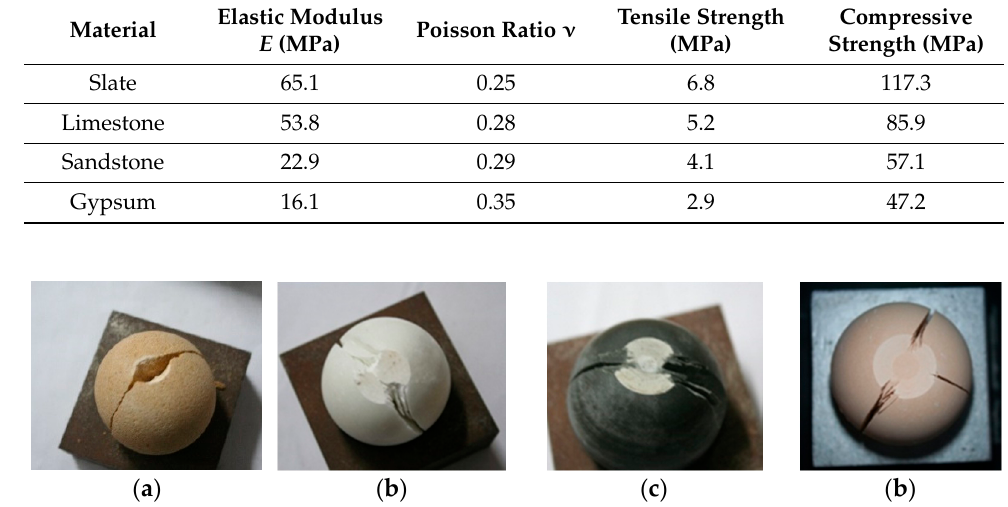
Figure 2. Normal force–displacement curves of four spherical particles.